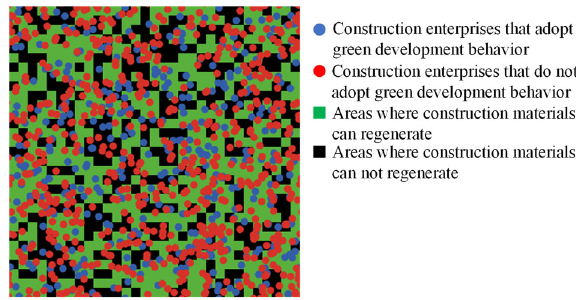
Fig. 1 The main view interface of the simulation model after initialization. It shows the random distribution of construction enterprises adopting green development behaviors and not adopting green development behaviors in the “ world ” at the initial state of the simulation model.